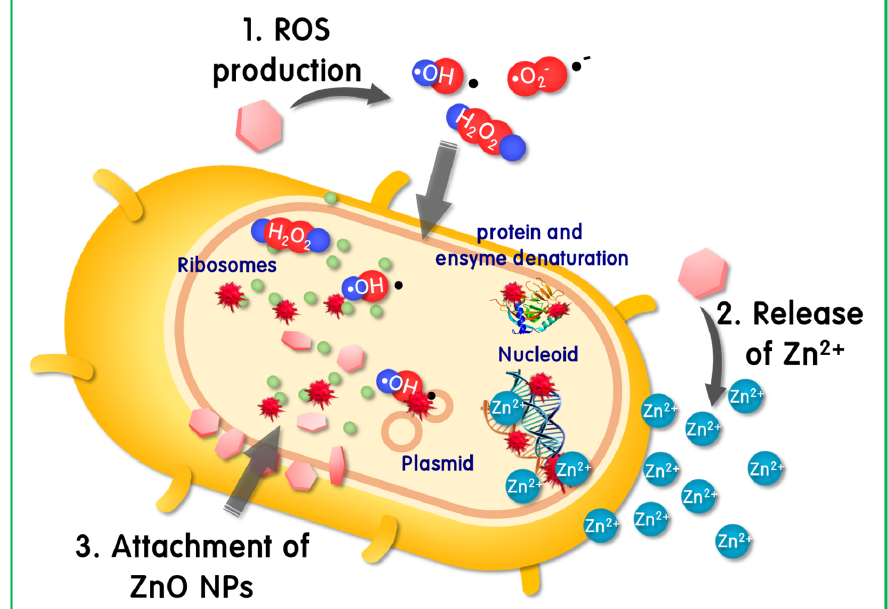
Scheme 1. Proposed antibacterial activity mechanism in ZnO